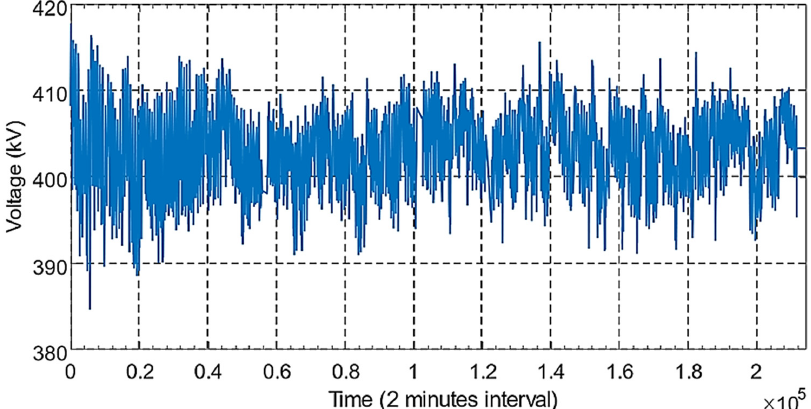
Figure 21. Evolution of the primary voltage